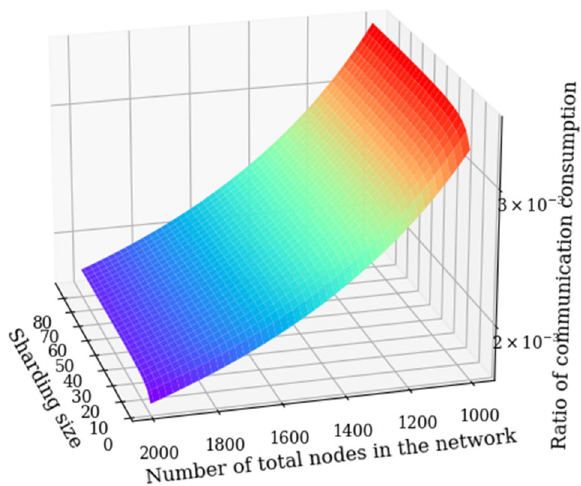
Figure 10. 3D graph of the ratio of